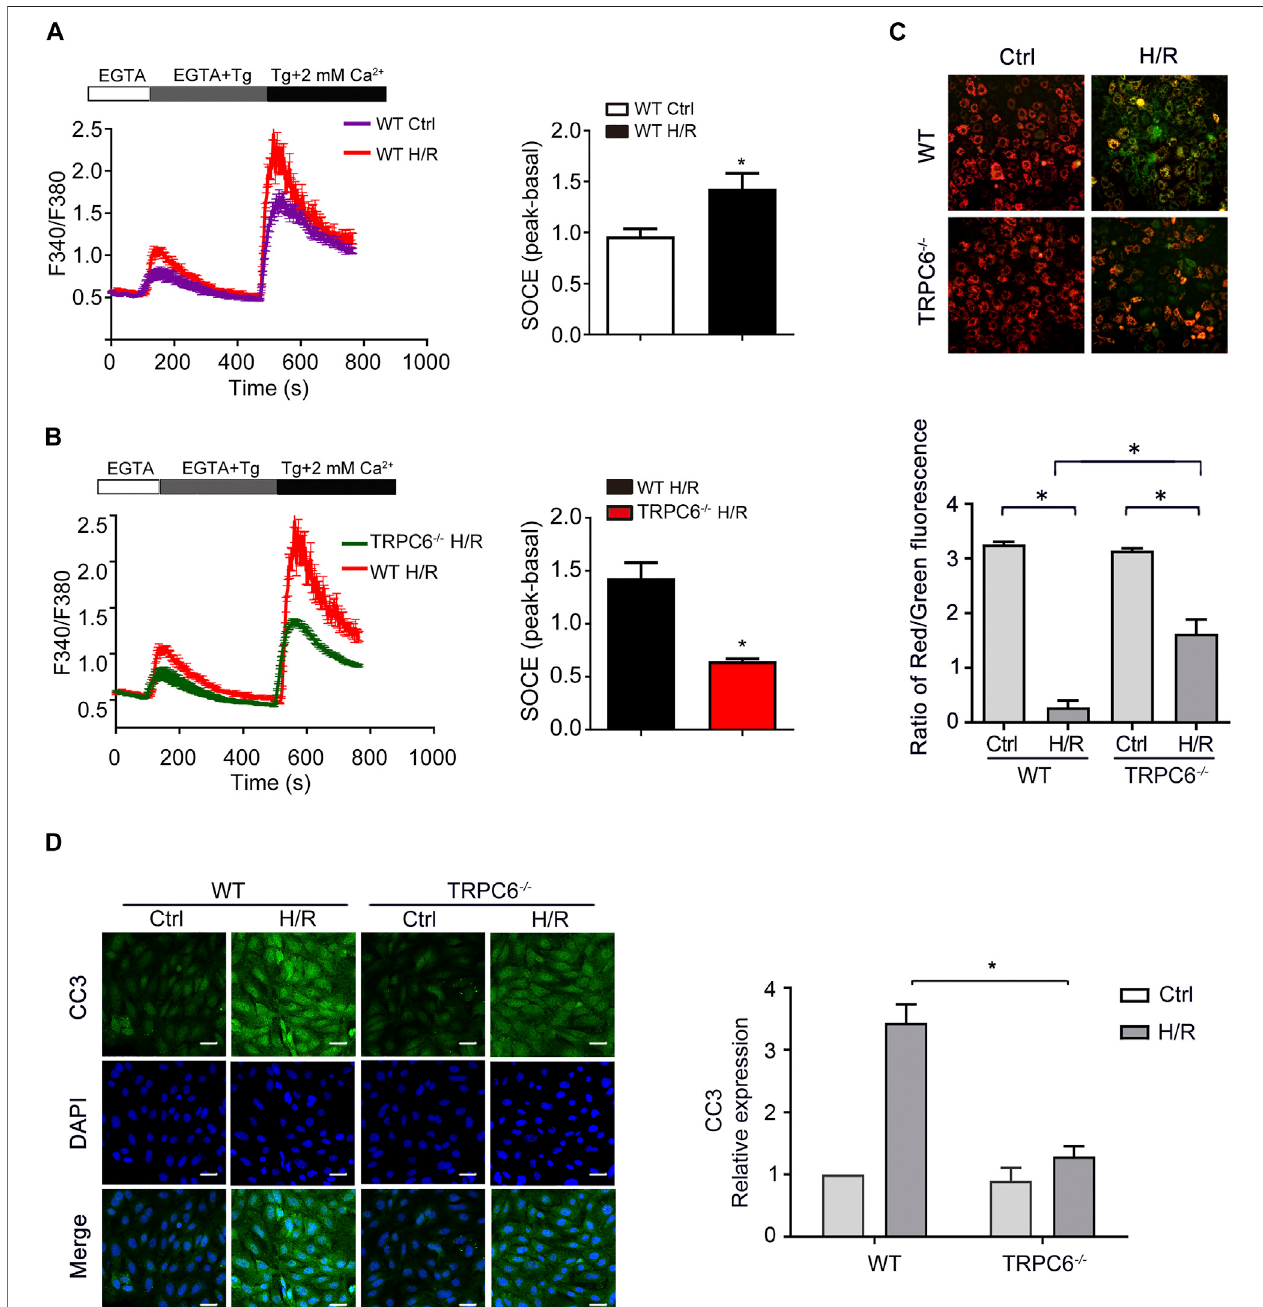
FIGURE 5 | TRPC6 knockout partly restores calcium in fl ux and apoptosis induced by H/R in vitro . (A, B) Representative traces showing thapsigargin-induced SOCEafterH/RtreatmentinWTandTRPC6 − / − mice.Quanti fi cationofpeakSOCEvaluesisexpressedasmean ± SEM, n (cid:2) 3(40 – 60cellsperexperiment),* p < 0.05. (C) MMP changesofprimaryTECs afterH/R injuryweremeasured withJC-1dye.Fluorescent imageswerephotographed bya fl uorescencemicroscopeatamagni fi cation of × 200 (scale bar: 50 μ m). Bars represent mean ± SEM, n (cid:2) 10, * p < 0.05. (D) Representative confocal microscopy images of CC3 expression in primary TECs from WT and TRPC6 − / − mice upon H/R treatment (photographed at a magni fi cation of × 200, scale bar: 50 μ m). Bars represent mean ± SEM, n (cid:2) 6, * p < 0.05.